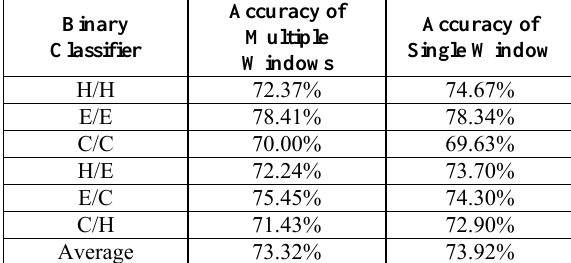
Table 3 Simulation II: Single Window vs. Multiple